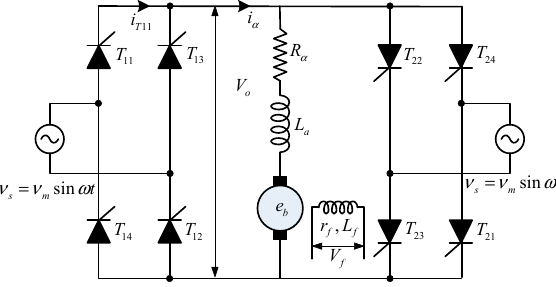
Figure 7. Single-phase fully-controlled dual converter drive.